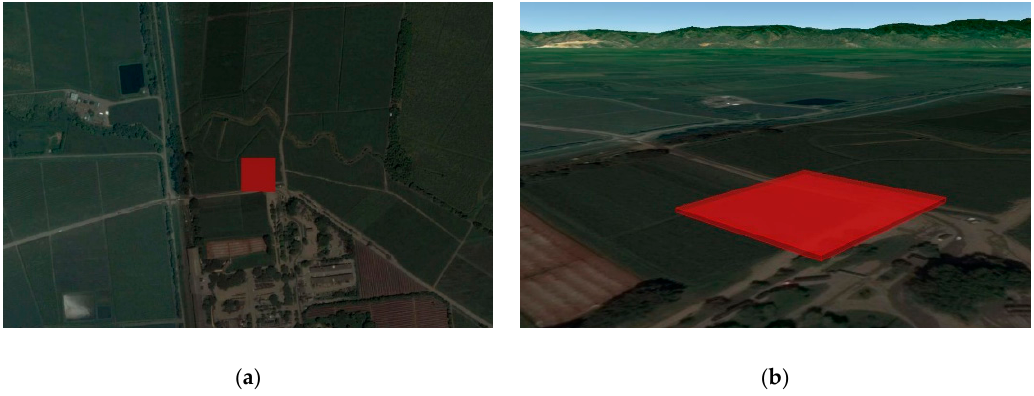
Figure 1. ( a ) Top; and ( b ) perspective view of the sugarcane area selected in this work to illustrate the estimation of the influence area generated by agricultural burning. The red square represents a burning area of 1 ha.